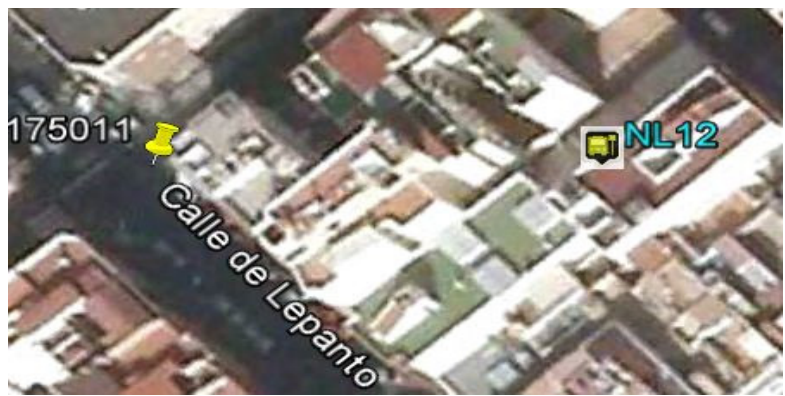
Figure 10. Aerial view of an example of GPS error at a stop in an urban environment.